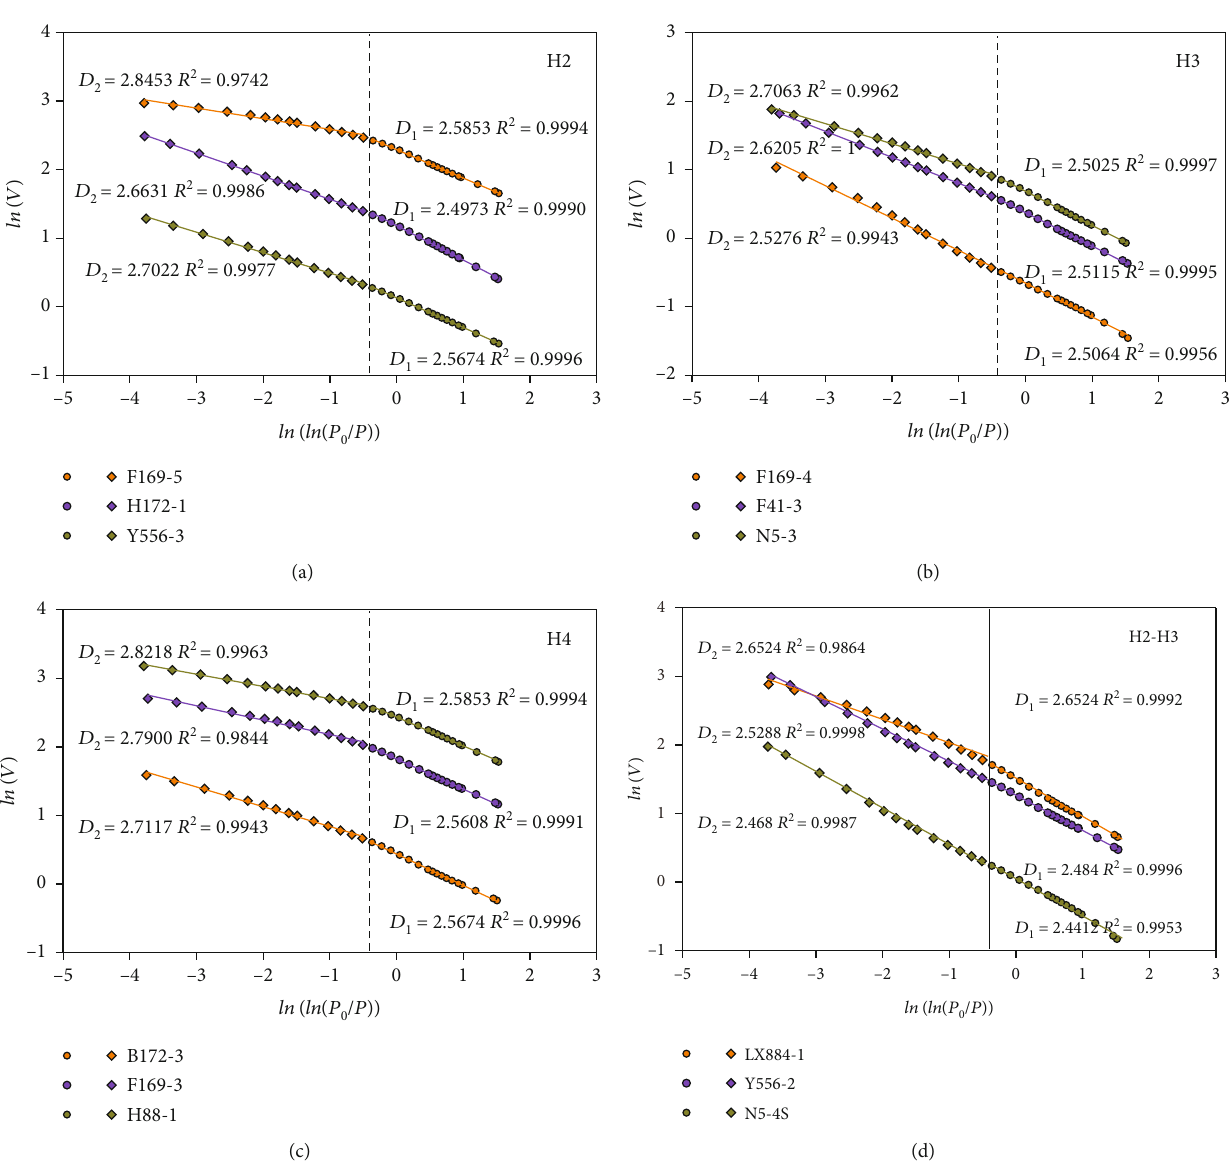
Figure 5: Fractal calculation results from ln ð V Þ vs. ln ð ln ð P / P